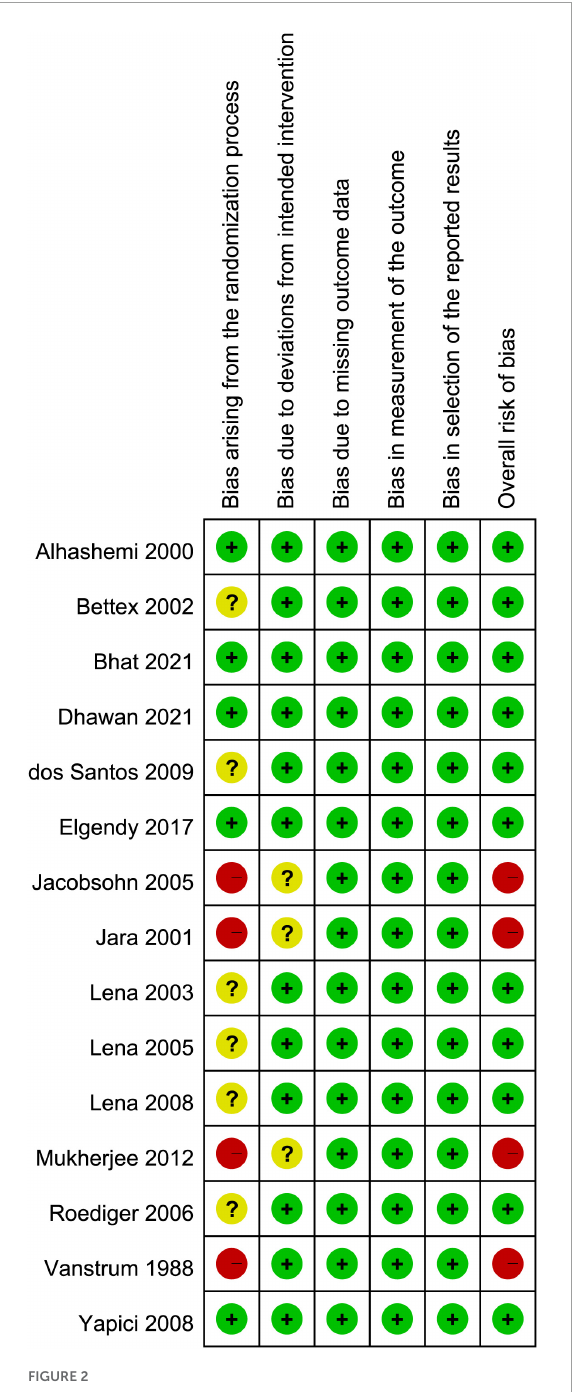
FIGURE2 Risks of bias of the included studies.